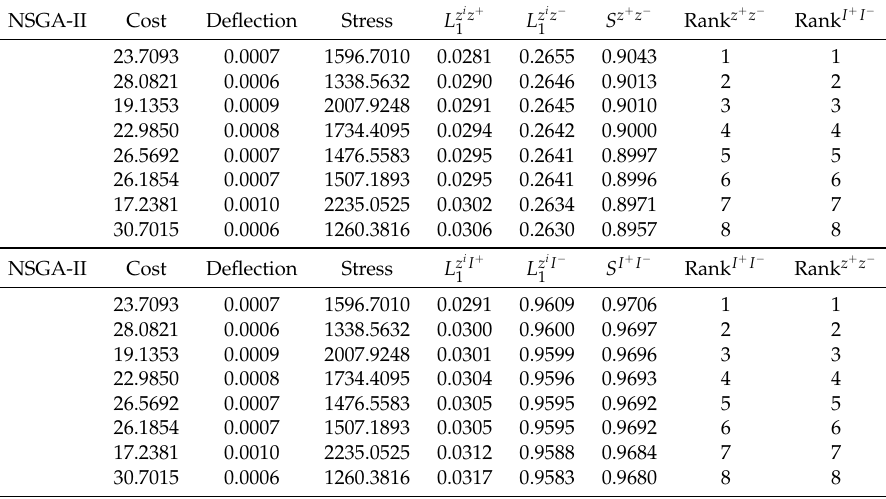
Table 8. TOPSIS ranking results with L 1 metric for